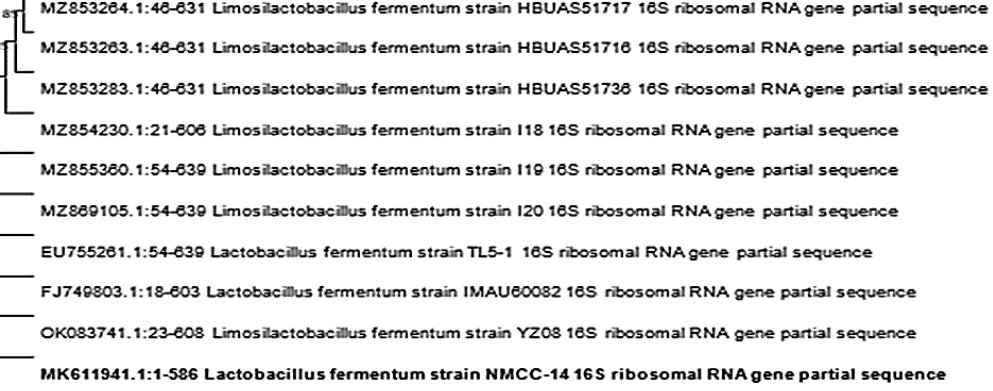
Figure 8. Phylogenetic tree of Lactobacillus fermentum NMCC-14 bacterial strain. Bootstrap values can be seen at each node.